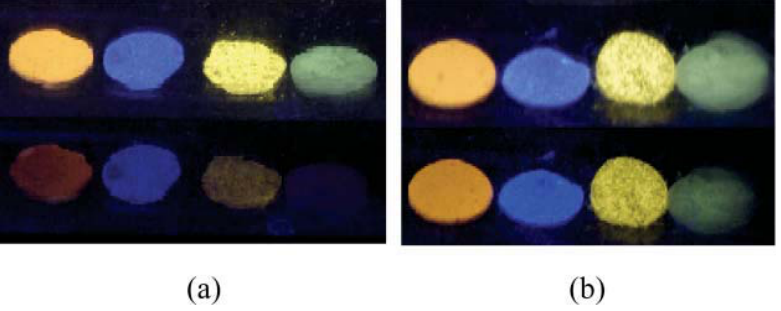
Figure 12. Visible detail of the initial versus diminished light emission seen from the array of Sn 2+ pressed pellets (left to right: SnSO exposed to (a) 100 ppm of pyridine and (b) 1 ppm pyridine. Reproduced with permission from